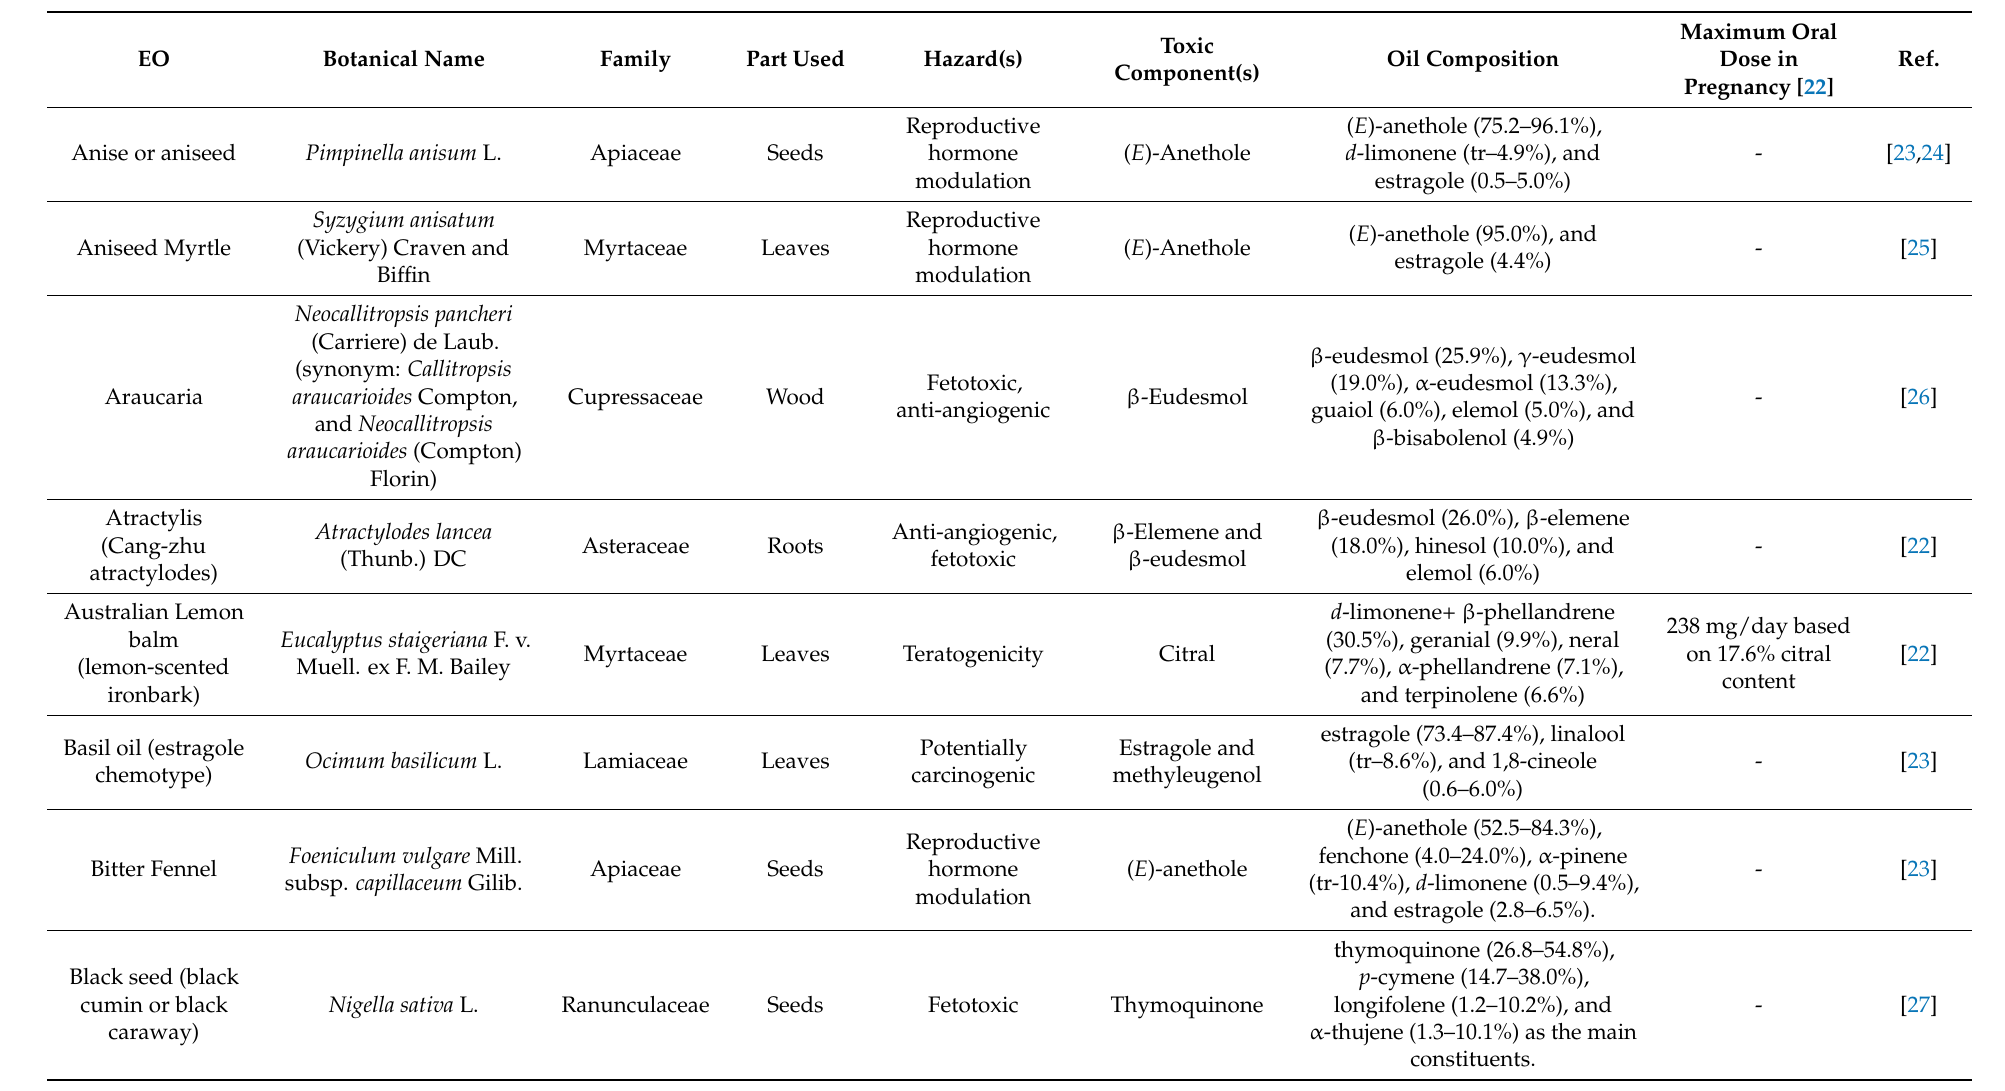
Table 1. Potentially toxic essential oils and their toxic constituents discussed in this